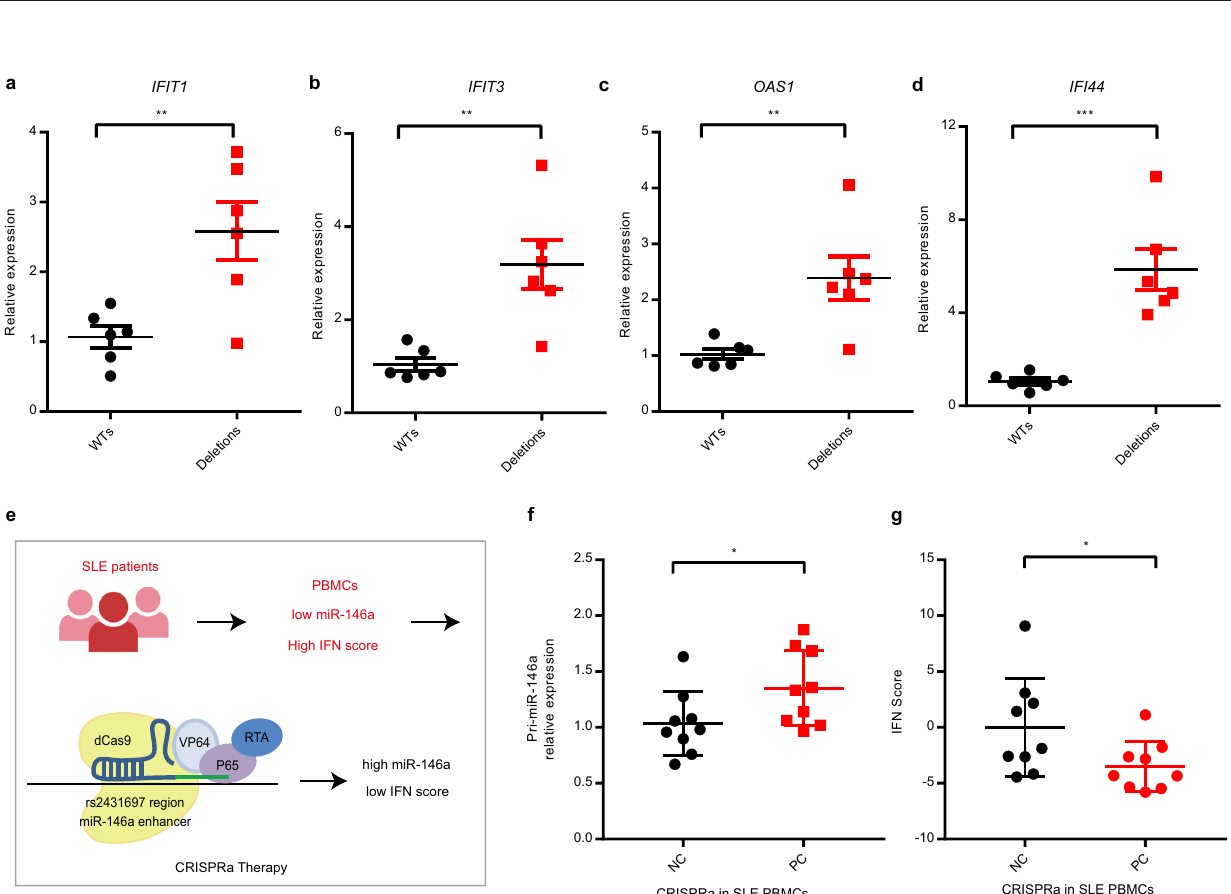
Fig. 6 Targeting rs2431697 intervenes with the activation of the interferon pathway by modulating miR-146a expression. a – d RT-qPCR analysis of interferon-inducible gene expression in U-937 WT and deletion clones after treating with Interferon- α ( IFIT1 : ** P = 0.0067, ** IFIT3 : P = 0.0027, ** OAS1 : P = 0.0066, *** IFI44 : P = 0.0003) ( n = 6, replicates represent unique biological clone replicates). e Flow scheme of inhibiting SLE IFN pathway by CRISPR activation (CRIPSRa) approach. f RT-qPCR analysis of Pri-miR-146a expression in SLE patients ’ PBMCs after treating with the CRISPRa system targeting the rs2431697 locus, * P = 0.0204 ( n = 9, replicates represent biological samples from unique individuals). g CRISPRa therapy decreases the IFN score of SLE patients ’ PBMCs based on sgRNAs targeting the rs2431697 site, * P = 0.0158 ( n = 9, replicates represent biological samples from unique individuals). Data are represented as mean ± SEM, and P -values are calculated using unpaired two-tailed Student ’ s t -test ( a – d ) and paired two-tailed Student ’ s test ( f , g ). * P < 0.05; ** P < 0.01; *** P <